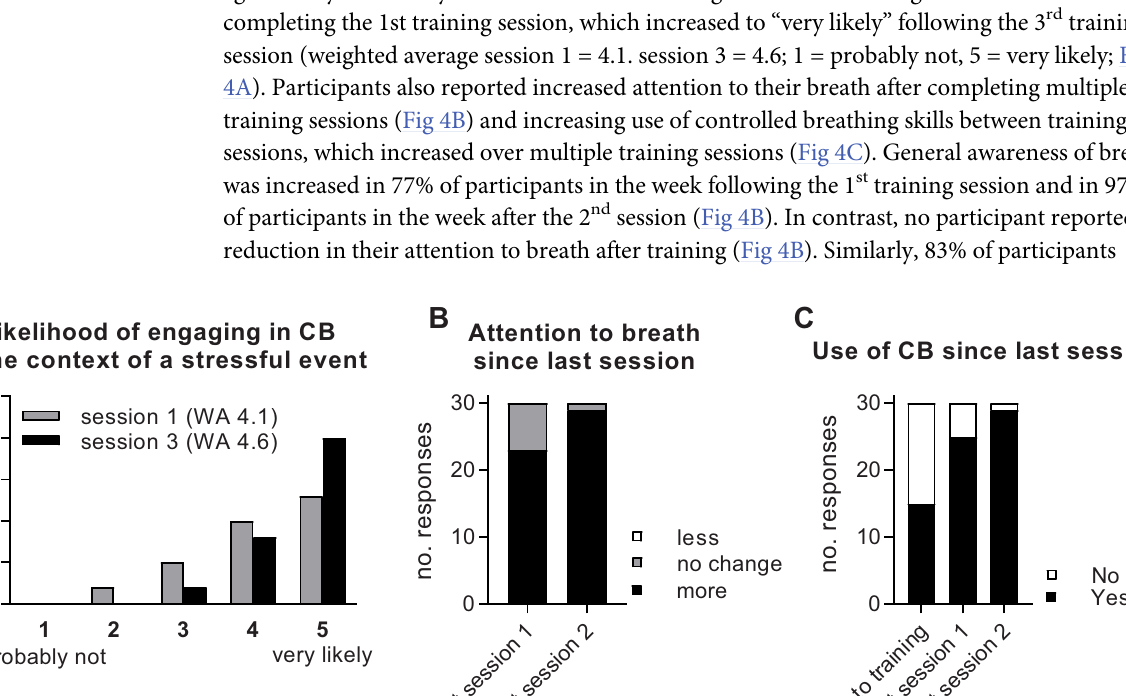
PLOS ONE | https://doi.org/10.1371/journal.pone.0245068 February 2,